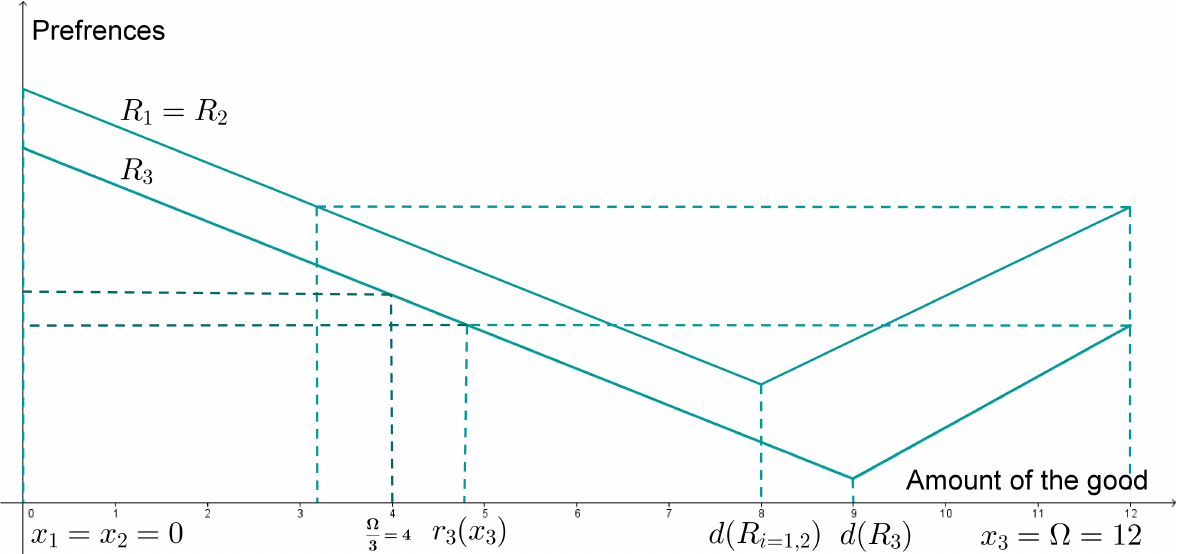
Figure 2. The NE correspondence, the I correspondence fail to satisfy no-veto